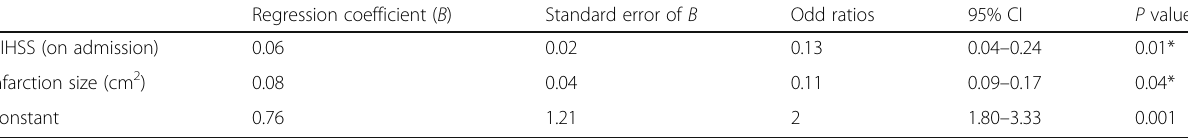
Table 6 Multiple linear regression analysis model for significant indicators of short-term